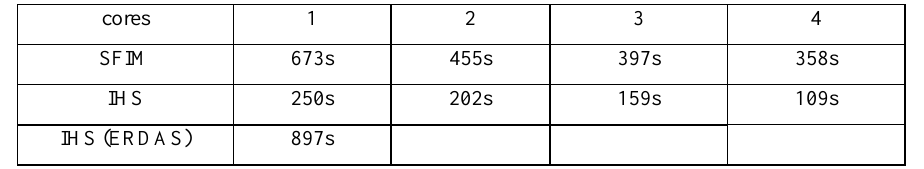
Tab. 1 Process times for fusion algorithms with different CPU